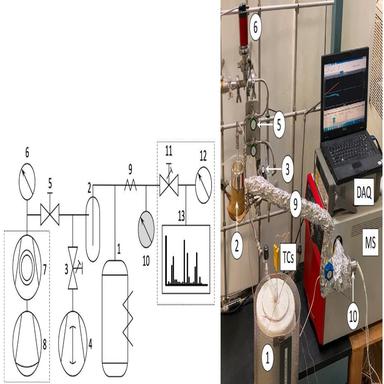
Left: Schematic drawing of the experimental apparatus. The numbers denote: 1 – furnace; 2 – liquid nitrogen cold trap; 3 – gas metering valve; 4 – roots pump; 5 – shut-off valve; 6 – combination Pirani / cold cathode ionization gauge (TPG); 7 – turbomolecular-drag pump (TMP); 8 – diaphragm pump, 9 – heated vacuum line, 10 – combination piezo / micro-Pirani gauge (μPG); 11 – variable leak valve (VLV); 12 – cold cathode ionization gauge (MSG); 13 – quadrupole mass analyzer. The dashed rectangles indicate inte